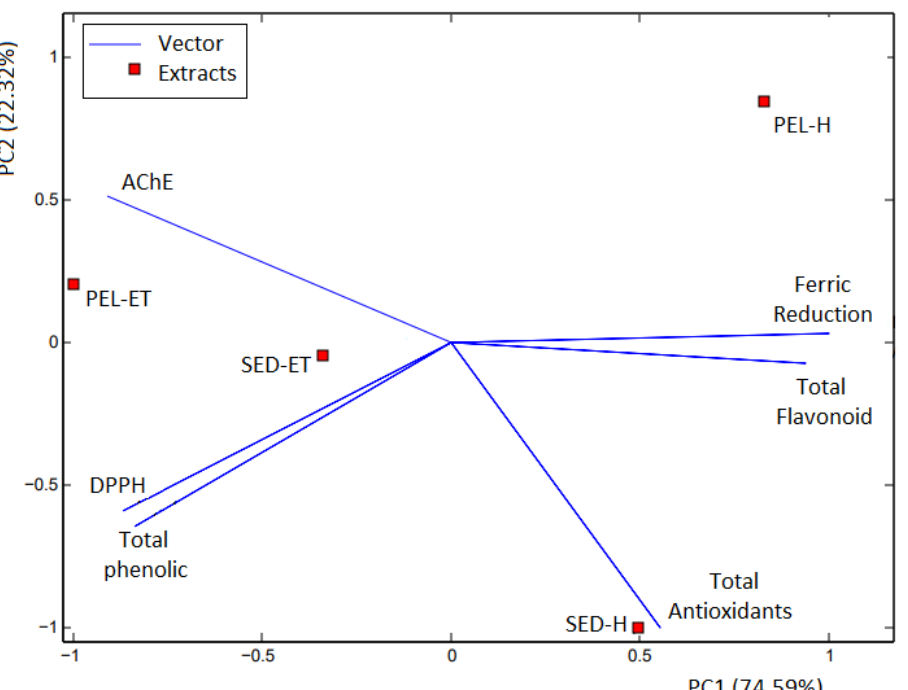
Figure 1. Principal component analysis biplot, PC1 versus PC2, correlating antioxidant responses, total phenolic content, total flavonoid content, and acetylcholinesterase (AChE) inhibitory activity. DPPH: 2,2-Diphenyl-1-picrylhydrazyl; SED-H: seed hexane extract; SED-ET: seed ethanolic extract; PEL-H: peel hexane extract, and PEL-ET: peel ethanolic extract.